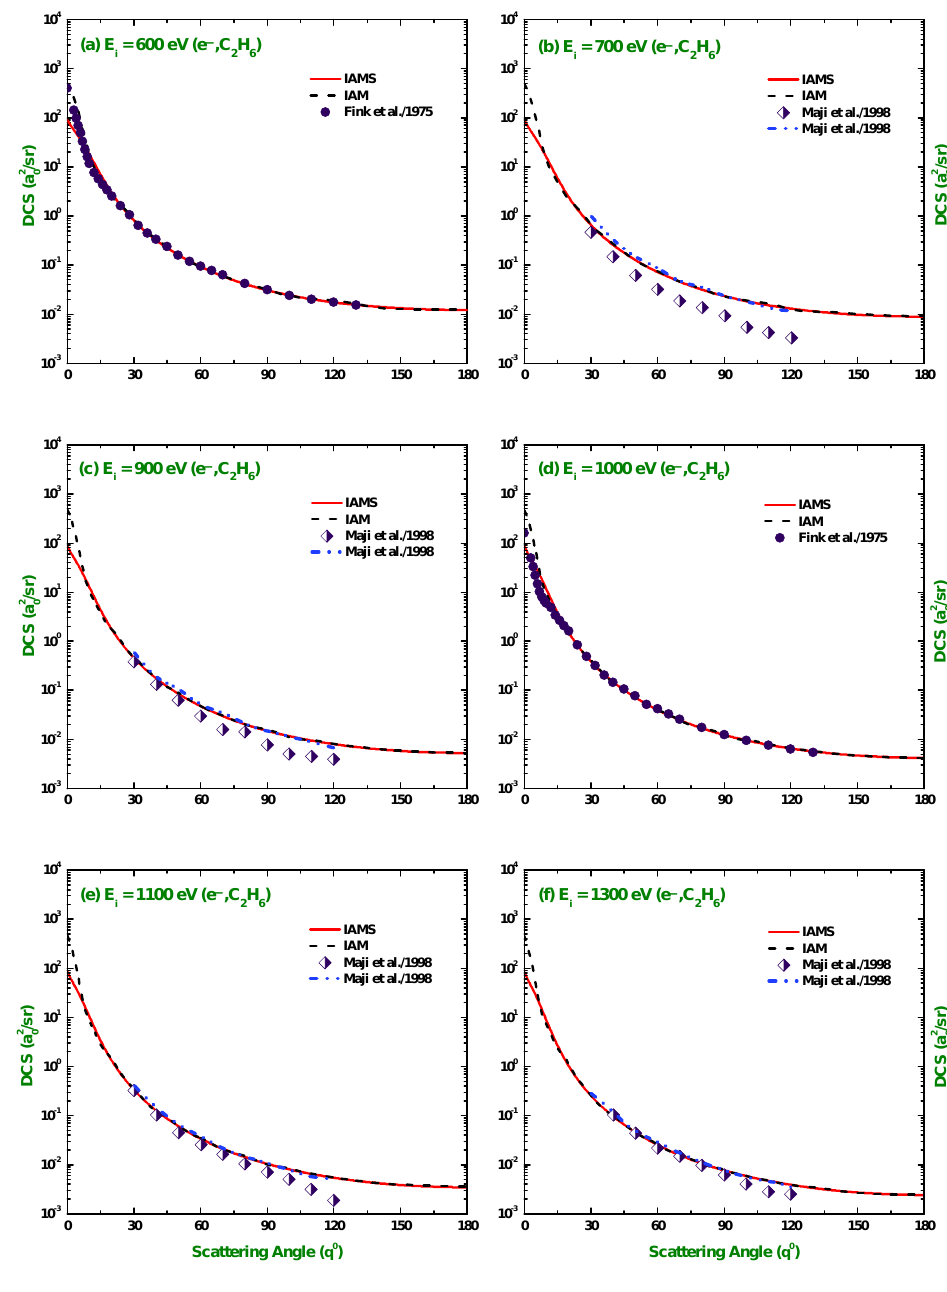
Figure 3. DCS ( a 2 / sr ) for the elastic scattering of electrons from C 2 H 6 at energies of 600, 700, 900, 0 1000, 1100, and 1300 eV. Theoretical works: References in Figures 1 and 2; Experimental works: References in Figures 1 and